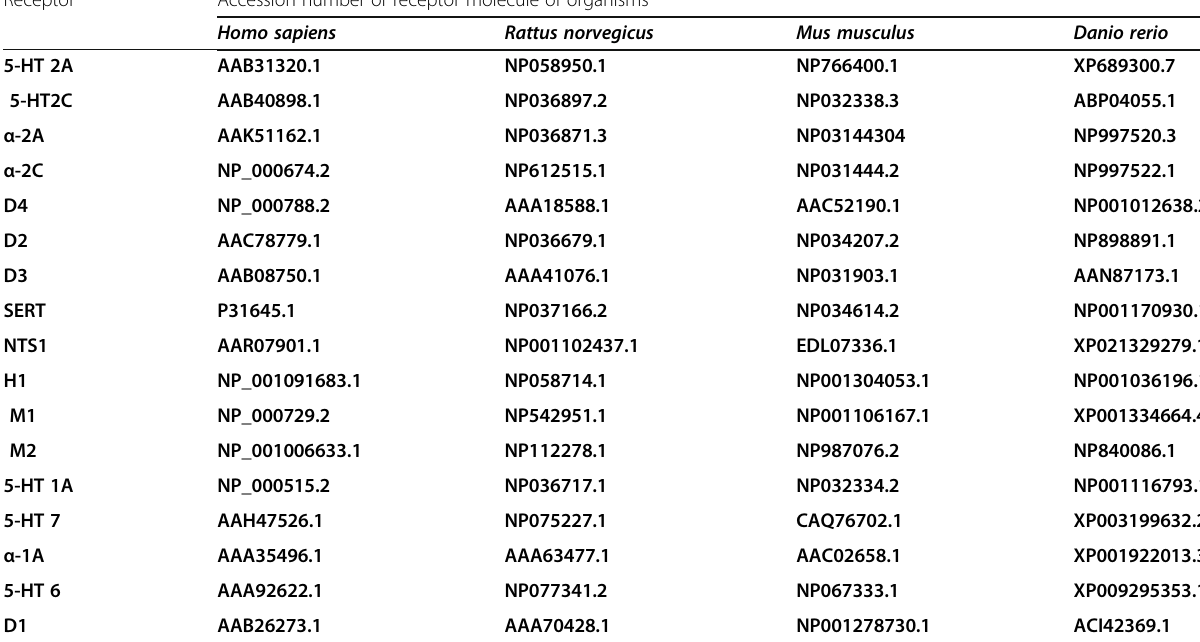
Table 1 Accession number of proteins retrieved from NCBI Receptor Accession number of receptor molecule of organisms Homo sapiens Rattus norvegicus Mus